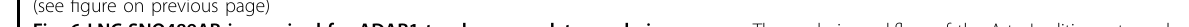
Fig. 6 LNC-SNO489AB is required for ADAR1 to play a regulatory role in cancer. a The analysis work fl ow of the A-to-I editing rate and dysregulated genes when LNC-SNO49AB is silenced in RS4;11. b The box plots showed a global decrease of RNA A-to-I editing levels in si-LNC- SNO49AB group. c Venn diagram showing overlap of genes that are dysregulated both in si-LNC-SNO49AB cells and si-ADAR1 cells. d GO analysis of 162 genes that are dysregulated in both si-LNC-SNO49AB cells and si-ADAR1 cells. e qRT-PCR validation of genes that were dysregulated in both si- LNC-SNO49AB cells and si-ADAR1 cells. Gene expression was normalized to GAPDH mRNA. Values are the means ± SEM of three independent experiments. ns, not signi fi cant, * P < 0.05, ** P < 0.01, and *** P < 0.001 by Student ’ s t -test. f Cell cycle analysis when ADAR1 was silenced via two independent siRNAs. Values are the means ± SEM of three independent experiments. *** P < 0.001 by Student ’ s t -test. g Colony numbers from leukemia cells with ADAR1 knocked down by siRNAs compared with the control (si-NC). Values are the means ± SEM of three independent experiments. ** P < 0.01 by Student ’ s t -test. h Effects of ADAR1 overexpression and/or LNC-SNO49AB knockdown on the cell cycle in NB4, MV4-11 and MOLM13 cells. Values are the means ± SEM of three independent experiments. *** P < 0.001 by Student ’ s t -test.